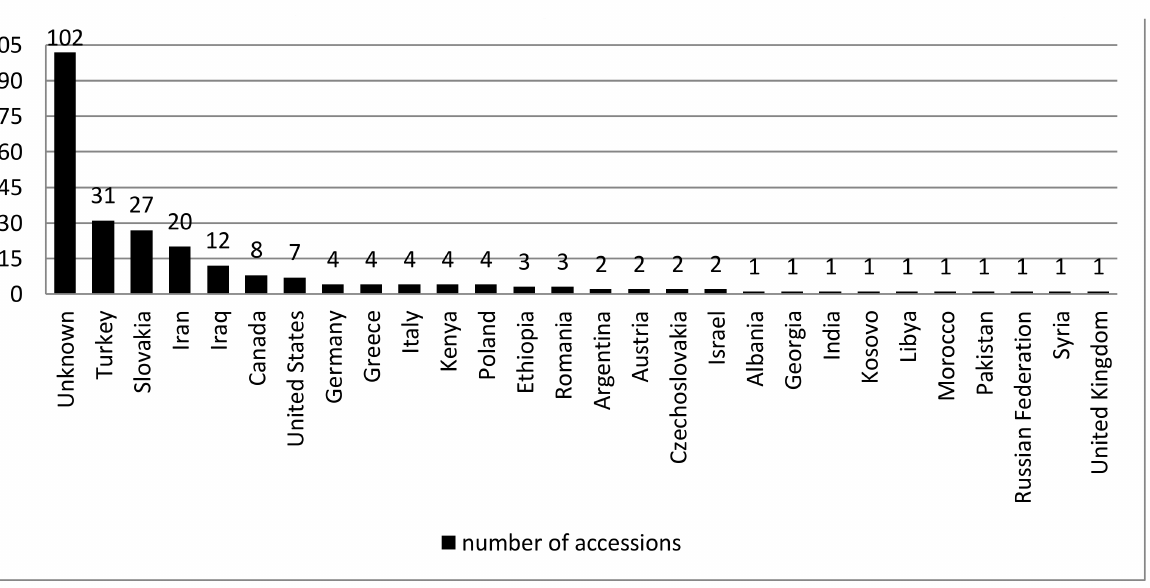
Figure 1. Origin of the analyzed A. fatua